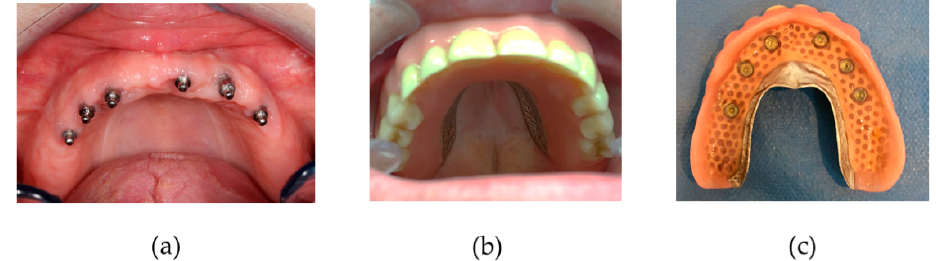
Figure 3. ( a ) Maxillary mini dental implant (MDI) position; ( b ) final denture in situ; ( c ) final denture palatal side with retention caps and o ‐ rings.